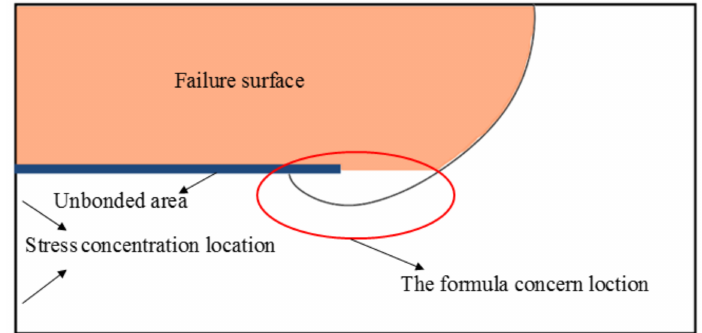
Figure 9. The formula concerned